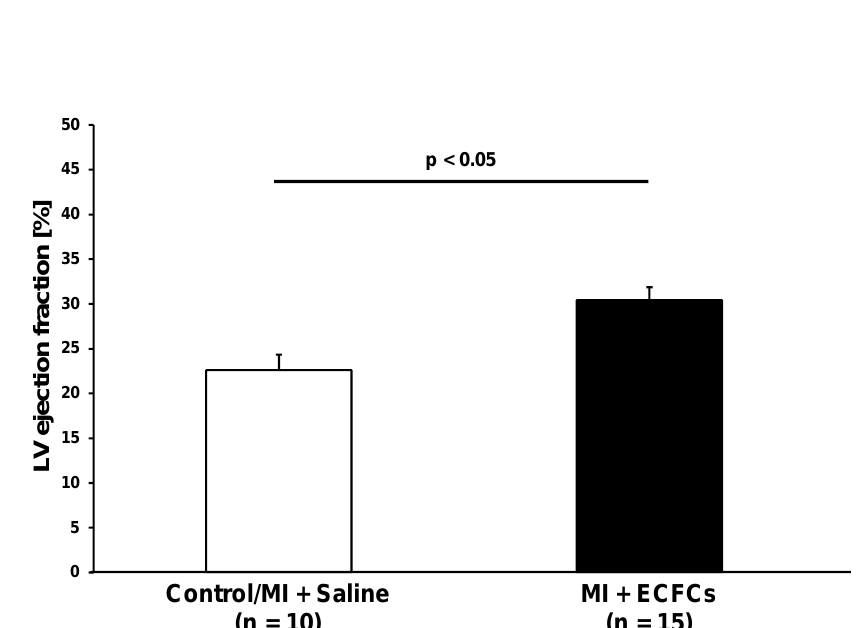
Figure 1. Improved myocardial function after human endothelial colony-forming cells (ECFC) transplantation into ischemic myocardium. Bar graphs representing cardiac output ( A ), contractility ( B ), and ejection fraction ( E ) in saline-treated animals (white bars) and ECFC-treated animals (black bars) 30 days after myocardial infarction (MI). Data represent mean ± SEM; n.s., not significant. Representative pressure volume loops of saline-treated animals ( C ) and ECFC-treated animals ( D ) 30 days after MI.